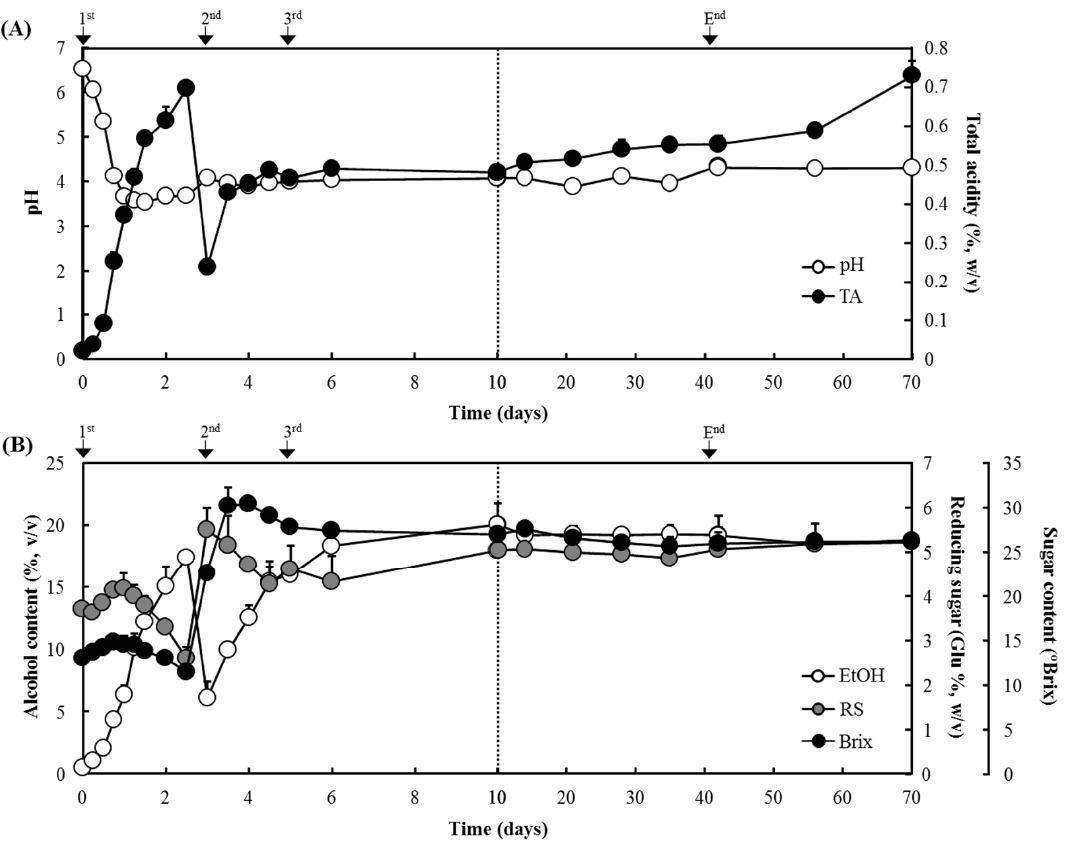
Figure 2. Changes in physicochemical characteristics during traditional Korean rice wine ( Gayangju ) fermentation. (A) pH ( ○ ) and total acidity (●); (B) contents of alcohol ( ○ ), reducing sugars ( ), and total soluble solids (●); (C) content of total phenol ( ○ ) and DPPH radical scavenging activity (●).